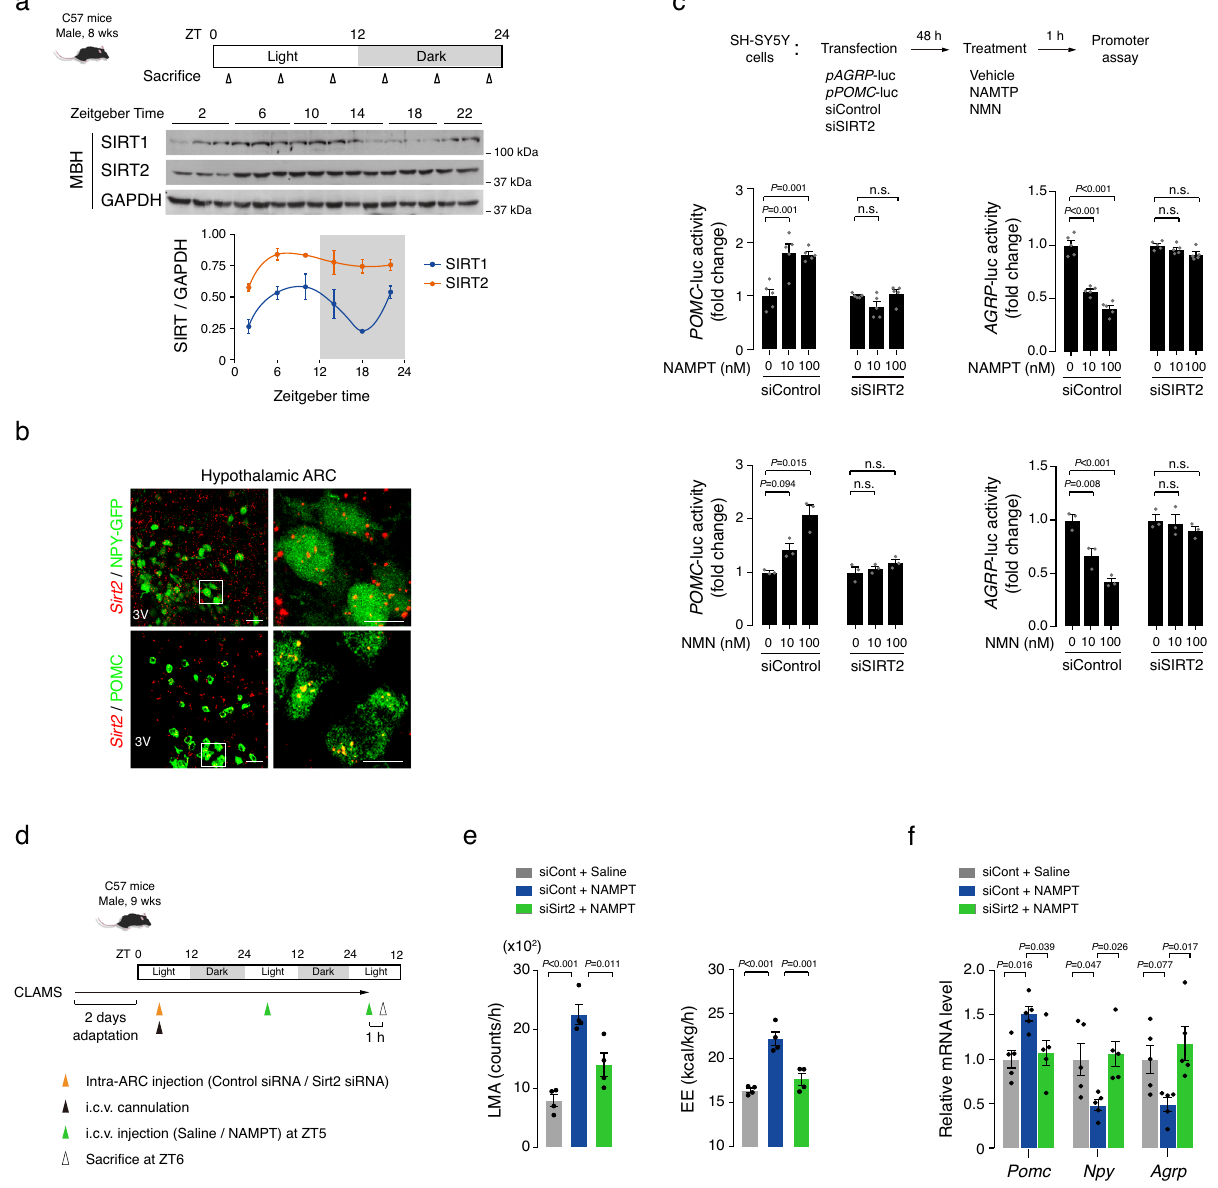
Fig. 5 | SIRT2 mediates the hypothalamic actions of eNAMPT. a Circadian pat- terns of the expression of SIRT1 and SIRT2 in the MBH of normal mice (ZT10, 22, n =2; other groups, n =3 mice). Two independent replicates were performed. ZT zeitgeber time. b Representative images of Sirt2 fl uorescent in situ hybridization and POMC (ß-endorphin) or NPY-GFP immuno fl uorescence double staining showing Sirt2 expressioninthePOMCandNPY/AgRPneuronsof thehypothalamic arcuate nucleus (ARC). Two independent replicates were performed. Scale bars = 25 μ mand10 μ m(magni fi edimages). c EffectsofNAMPT/NMNtreatmenton POMC and AGRP promoter activities in SH-SY5Y cells with or without SIRT2 knockdown